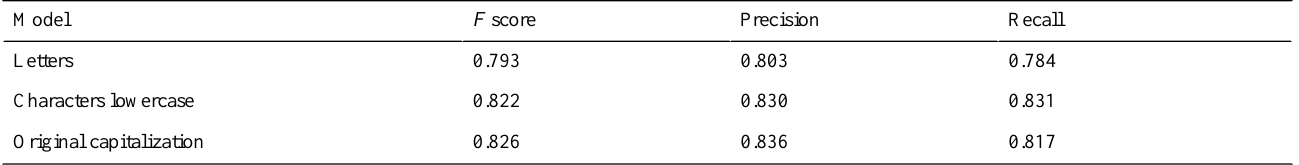
Table 3. The IVF 35 Ages + classification results; 10-fold cross-validation, 30 authors, 100 posts per author.